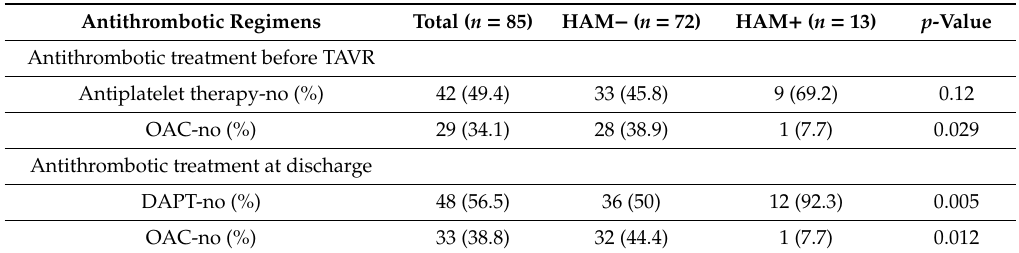
Table 3. HAM according to antithrombotic regimens.